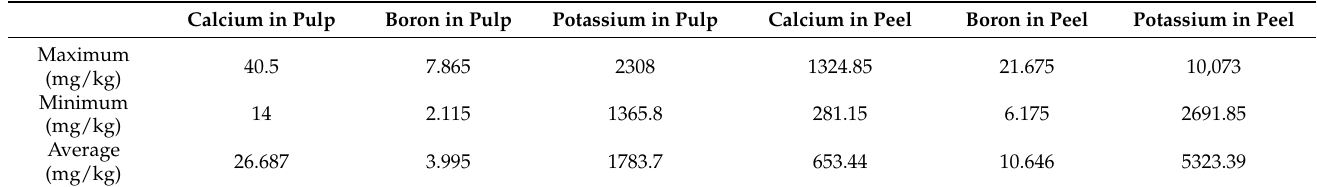
Table 1. Overview of mineral elements’ content